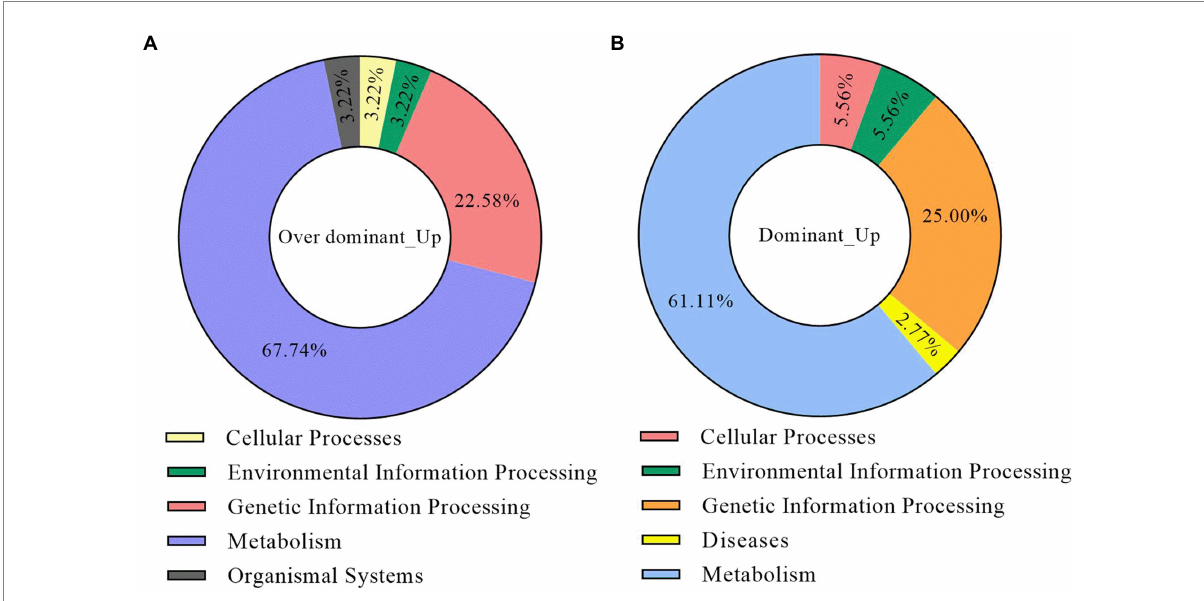
FIGURE 6 The KEGG pathway enrichment analysis of the non-additive upregulated DEGs. (A) The classification of the KEGG enrichment results for dominant upregulated DEGs. (B) The classification of the KEGG enrichment results for the over-dominant upregulated